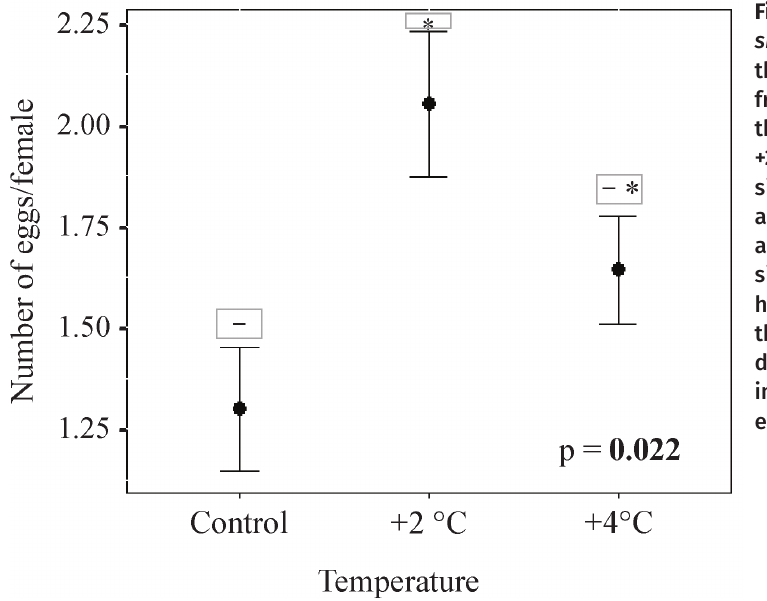
Figure 2. Box plot showing C. silvestrii fecundity (average of the number of eggs/ female from the three clutches) at three temperatures (control, +2, and +4°C), Kruskal-Wallis significant analyses (p = 0.022) are shown. Symbols (-,*) above the columns indicate significant differences (post- hoc analyses) - treatments that share a symbol do not differ significantly, p >0.05. • indicates the mean, ± standard error bars are